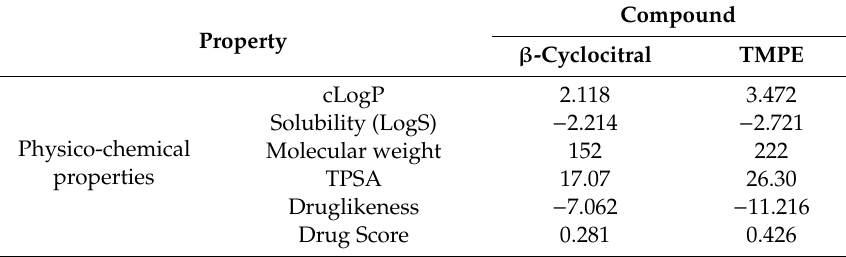
Table 3. OSIRIS toxicological and physicochemical predicted